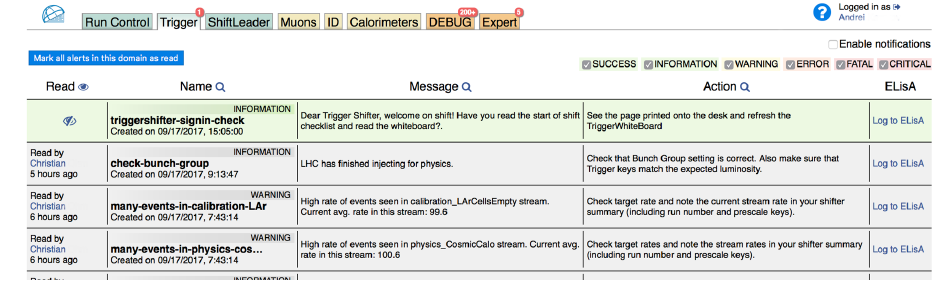
Figure 3. A screenshot of SA web application with few alerts (one not yet acknowledged)